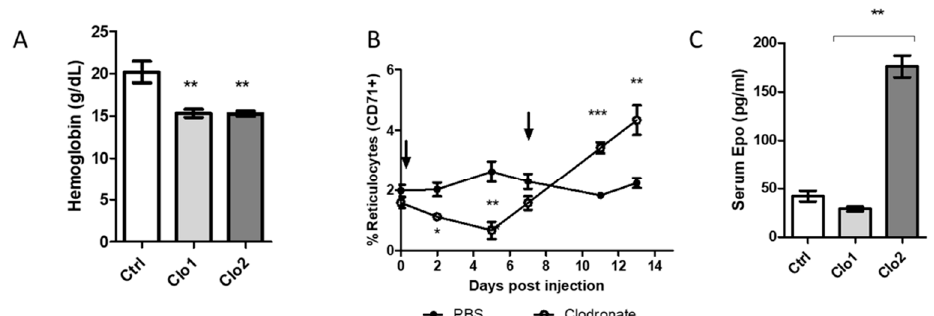
Figure 3. Impact of clodronate liposomes on blood hemoglobin, reticulocytes and serum levels of EPO. Macrophages were ablated by a single (1 week length) or two (2 weeks length) injections of clodronate liposomes. ( A ) Hemoglobin levels in peripheral blood were measured with the Drabkin method. ( B ) Percentages of circulating reticulocytes were quantified in blood with an anti-CD71 antibody. ( C ) Serum EPO concentrations were determined by ELISA. *** p < 0.001, ** p < 0.01, * p < 0.05.